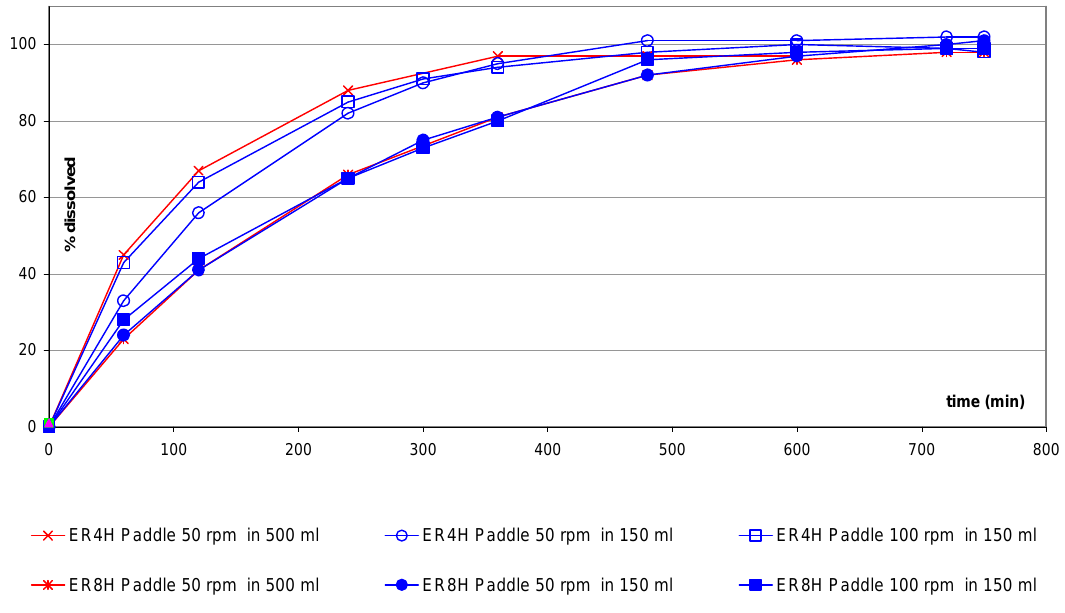
Figure 4. ER4H and ER8H tablets: comparison of small vessel accessories versus one liter vessel.